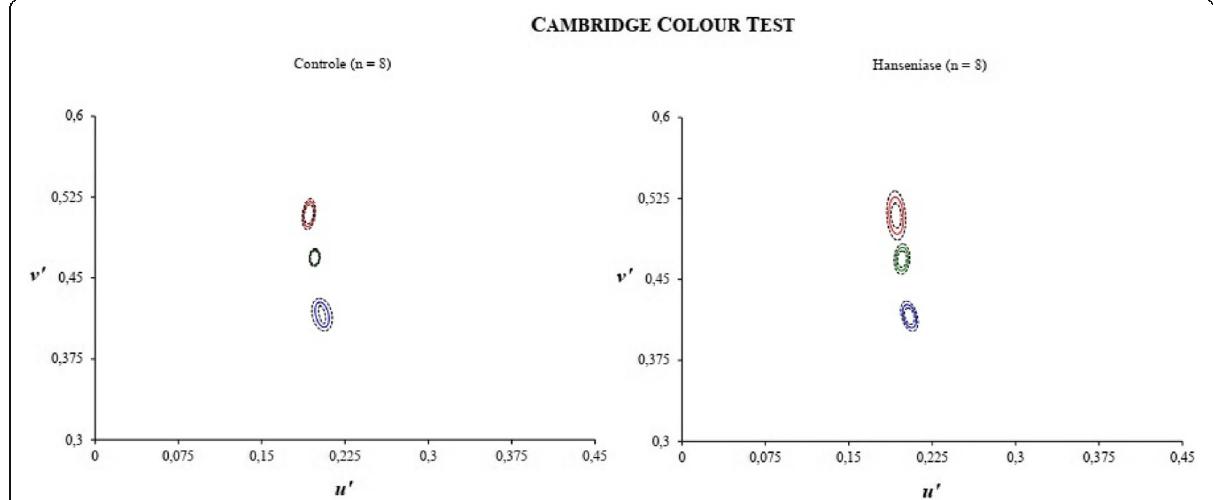
Fig. 4 Color discrimination thresholds assessed by CCT expressed as MacAdam ellipse areas in units of ( U'V' × 10 − 6 ) for subjects with normal vision and